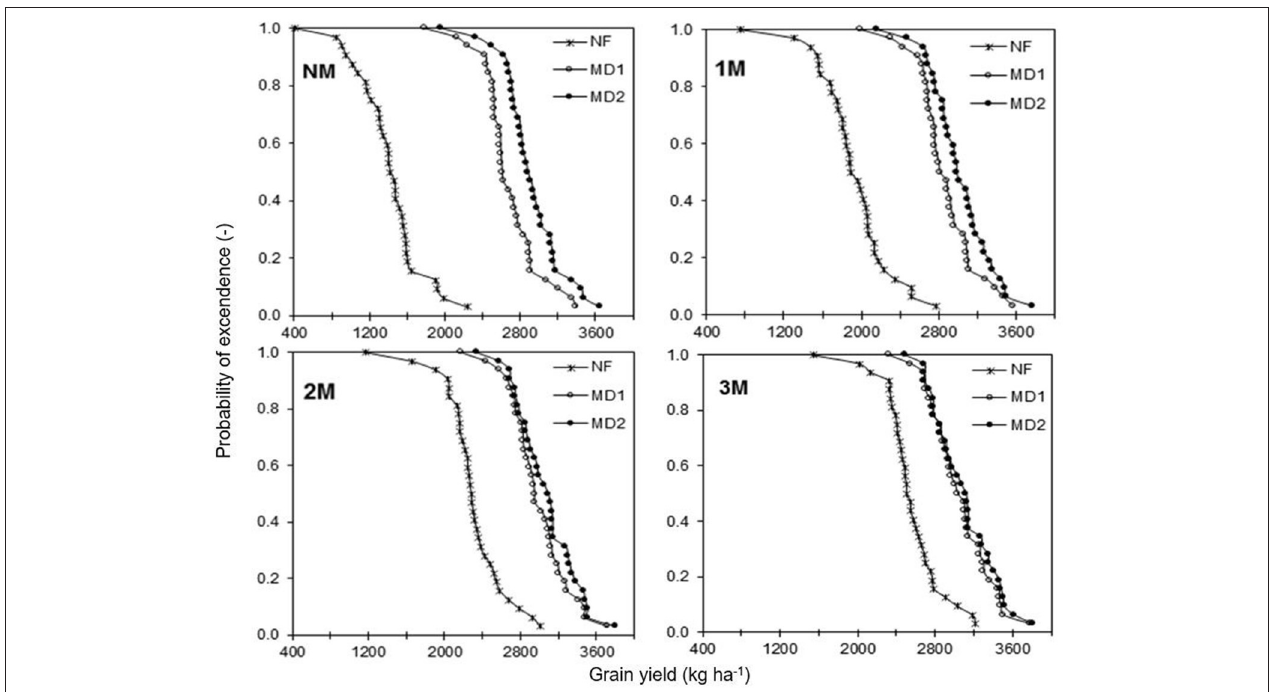
FIGURE 6 | Frequency distributions of maize grain yields as simulated by DSSAT over a 32 year period (1984 to 2015) in response to combined application of manure and fertilizer microdosing. NF, no fertilizer; NM, no manure; MD1, microdosing option 1; MD2, microdosing option 2. 1M, 2M, and 3M correspond to the application of 1, 2, and 3t ha − 1 of